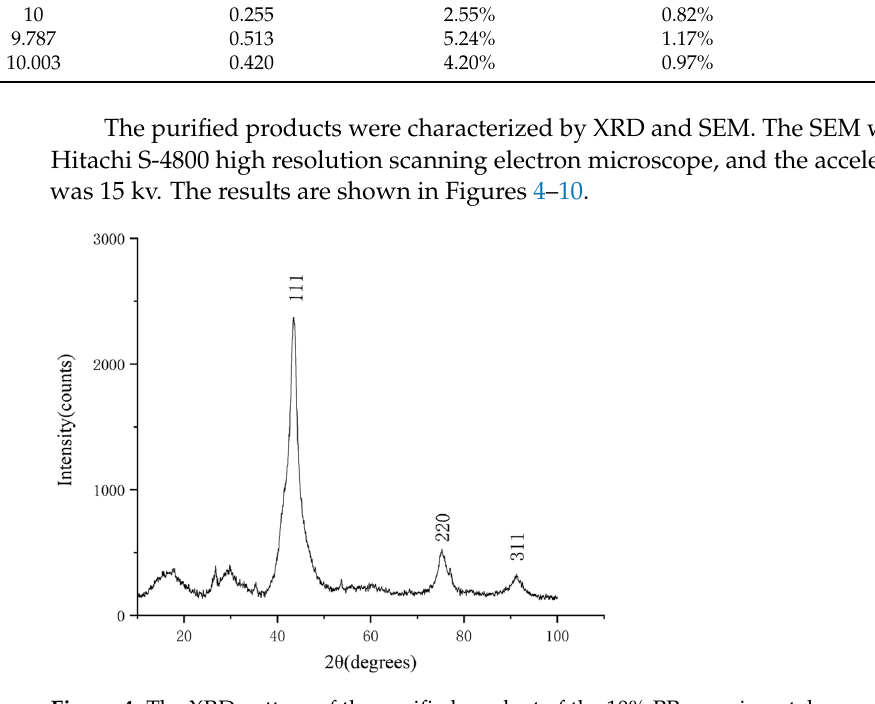
Figure 4. The XRD pattern of the purified product of the 10% PP experimental group. The horizontal coordinate indicates the diffraction angle and the vertical coordinate indicates the intensity of the diffraction peaks. The crystal planes corresponding to the three diffraction peaks are indicated.